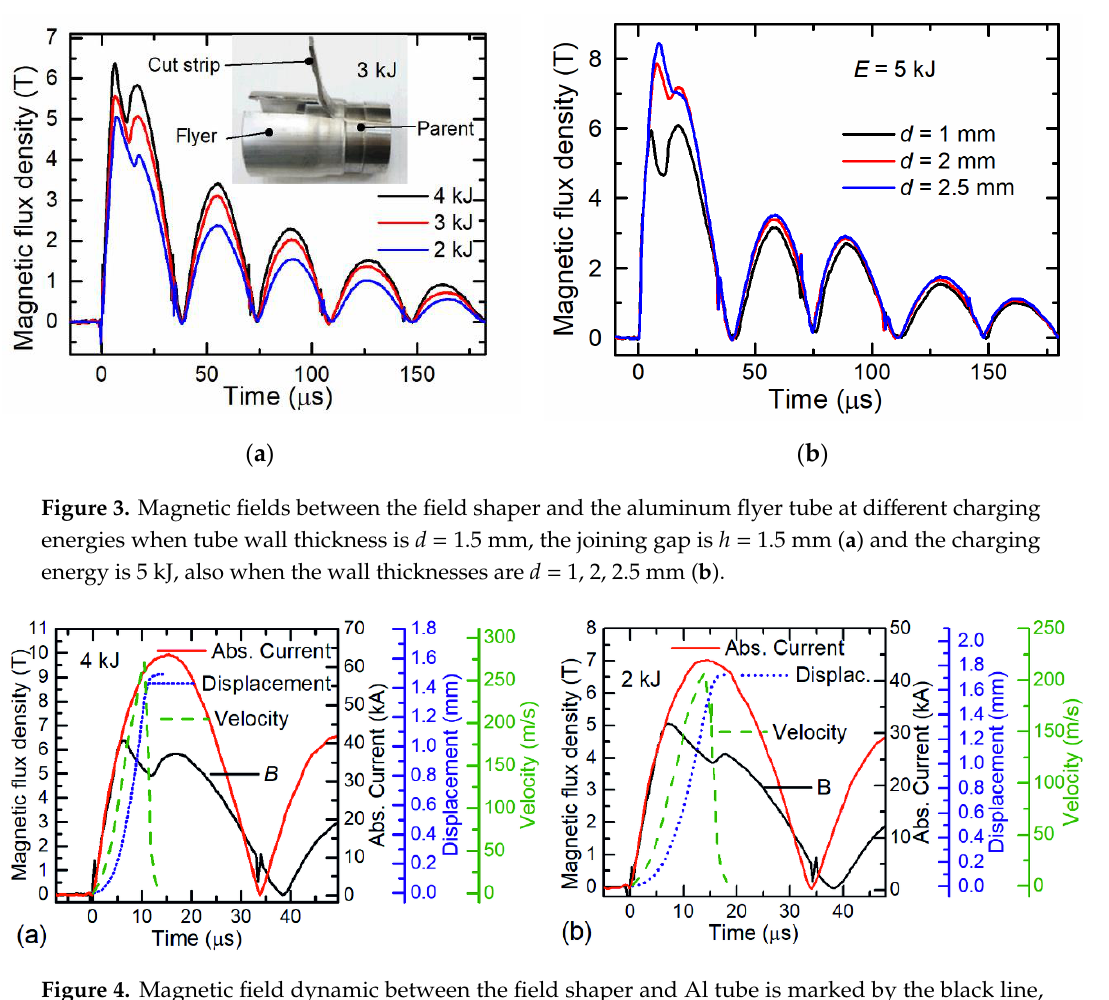
Figure 4. Magnetic field dynamic between the field shaper and Al tube is marked by the black line, the current of the coil by the red line, the displacement of the walls of tube by the dotted blue line and the velocity of the tube wall by the dashed green line. Tube walls thickness was 1.5 mm, the capacitor charging energy was 4 kJ ( a ) and 2 kJ ( b ). The parent was made of steel.